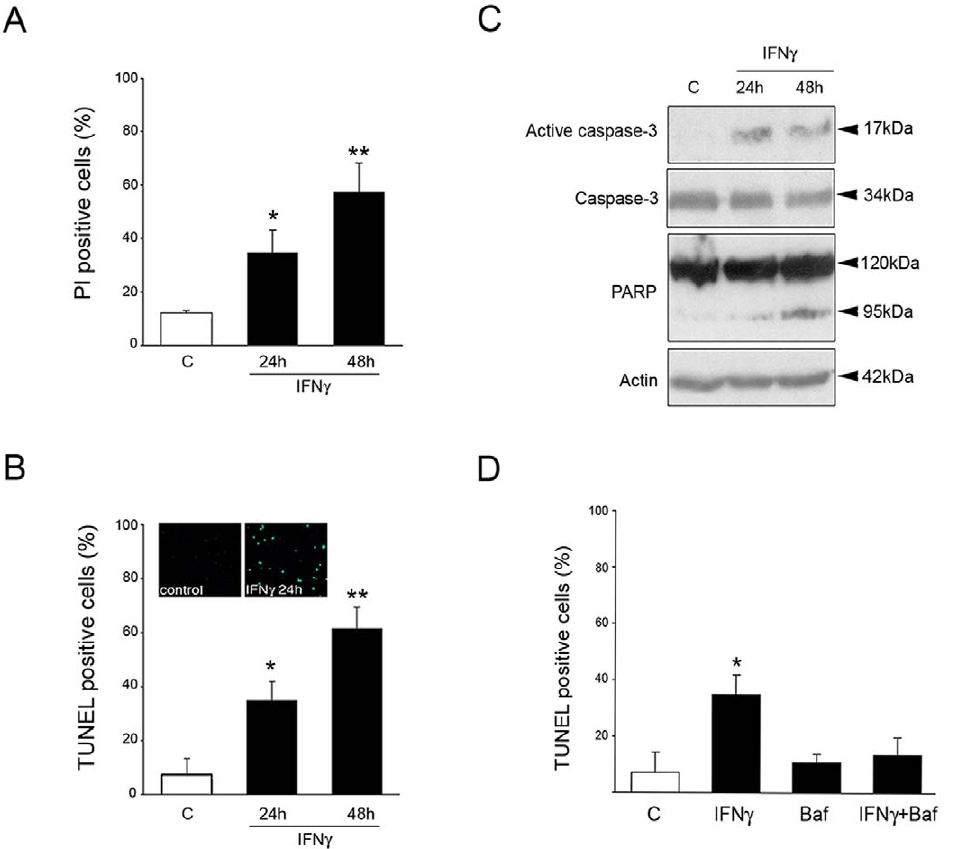
Figure 4. IFN c induces cell death in NPCs via caspase-3. NPCs were treated with 100 ng/ml IFN c for different time periods and analyzed further. *p , 0.05 and **p , 0.01 comparing IFN c treated vs. controls. ( A ) Number of propidium iodine positive cells was determined by counting. Values are means 6 SD, n=4. ( B ) Number of TUNEL positive cells. Values are means + SD, n=3. Inset show typical labeling in control and IFN c treated cells. ( C ) Immunoblot. Note increased active caspase-3 (17 kDa band) and cleaved PARP (89 kDa). Typical blot is shown and was repeated three times. ( D ) Effect of caspase inhibitor. NPCs were incubated for 24 h with 50 m M BAF in conjunction with IFN c . Values are means + SD, n=3.